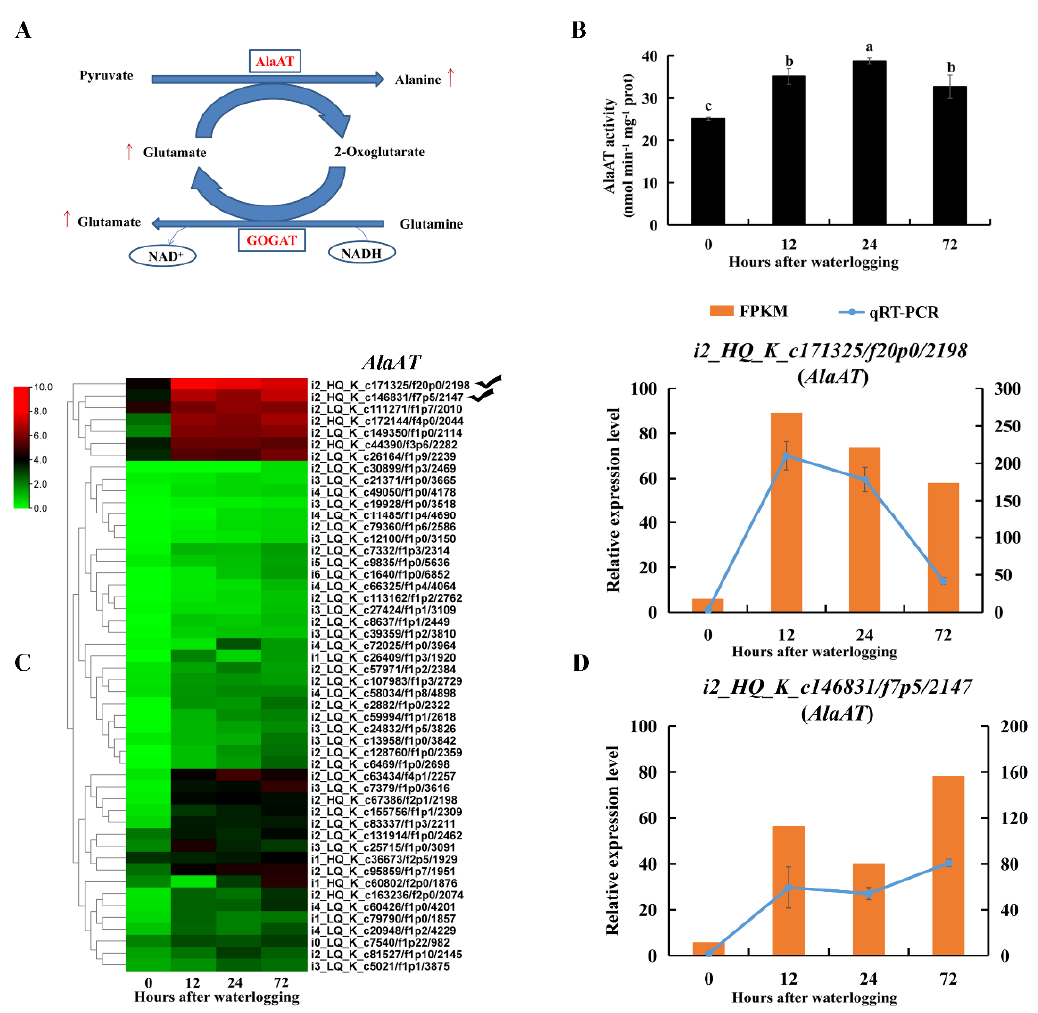
Figure 8. Changes in transcript level and enzyme activity of AlaAT in KR5 roots under waterlogging stress. ( A ) alanine and glutamate synthesis. ( B ) changes of the activity of AlaAT. ( C ) transcript levels of AlaATs . ( D ) RNA-Seq (right vertical axis) and qRT-PCR (left vertical axis) results for transcript changes in two AlaATs which were highly induced under waterlogging stress. In ( B ) data are expressed as averages ± SD, n = 3 and significant differences between treatments at p < 0.05 are indicated by different letters over columns (Duncan’s test).